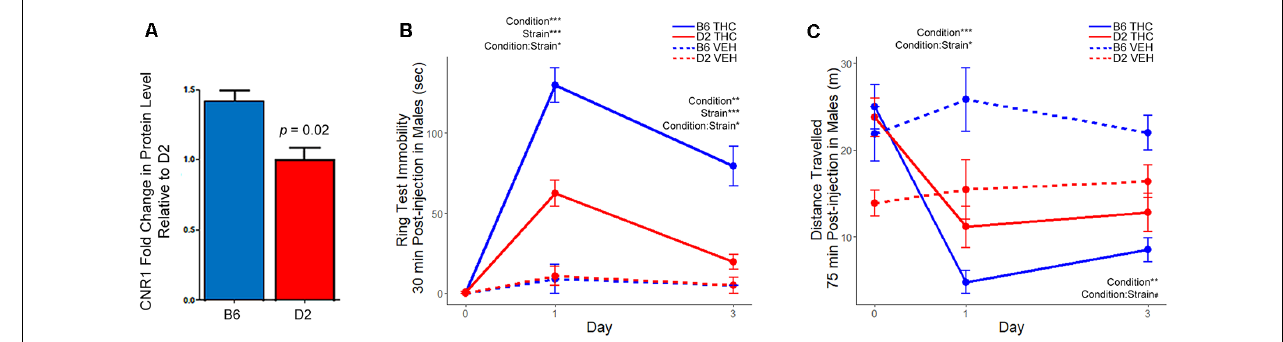
FIGURE 5 | Differential strain expression of cannabinoid receptor 1 (CNR1) protein in striatum and differential strain response to ∆ 9-tetrahydrocannabinol (THC). (A) Validation of CNR1 striatal expression between B6 and D2 using traditional Western blot analysis. Higher expression in the B6 strain relative to D2 was validated in the same samples used for proteomics analysis ( n = 3). Original membranes are shown in Supplementary Figure S1 . (B) The THC group included eight mice per strain and the vehicle (VEH) control group included two mice per strain. Multiple factor ANOVA was used to analyze the effect of condition, strain, and interaction effects on Days 1 and 3. There was a significant strain, condition, and strain-by-condition effect of THC on mobility in the ring test on Day 1 and 3. Male B6 mice exhibited more immobility relative to the D2 strain following THC treatment. (C) The THC group included eight mice per strain and the VEH group included two mice per strain. Multiple factor ANOVA was used to analyze the effect of condition, strain, and interaction effects on Days 1 and 3. There was a significant condition and strain-by-condition effect of THC on activity in the open field on Day 1. On Day 3, there was a significant condition, and trend for a strain-by-condition effect of THC on activity in the open field. Male B6 mice exhibited greater suppression of motor activity in the open field relative to the D2 strain following THC treatment. Note that the D2 vehicle control group ( n = 2) appeared to have much lower activity in the open field on Day 0. However, the study is designed such that all groups (treatment and vehicle control) also have baseline activity recorded on Day 0, mitigating the effects of the cohort effect observed in the D2 VEH group.